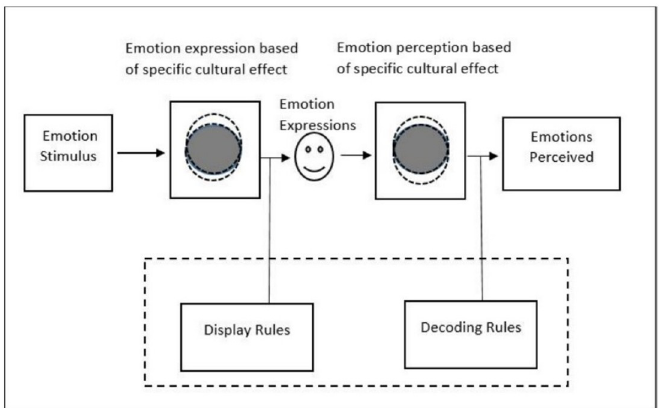
Fig 1. Dialect theory of